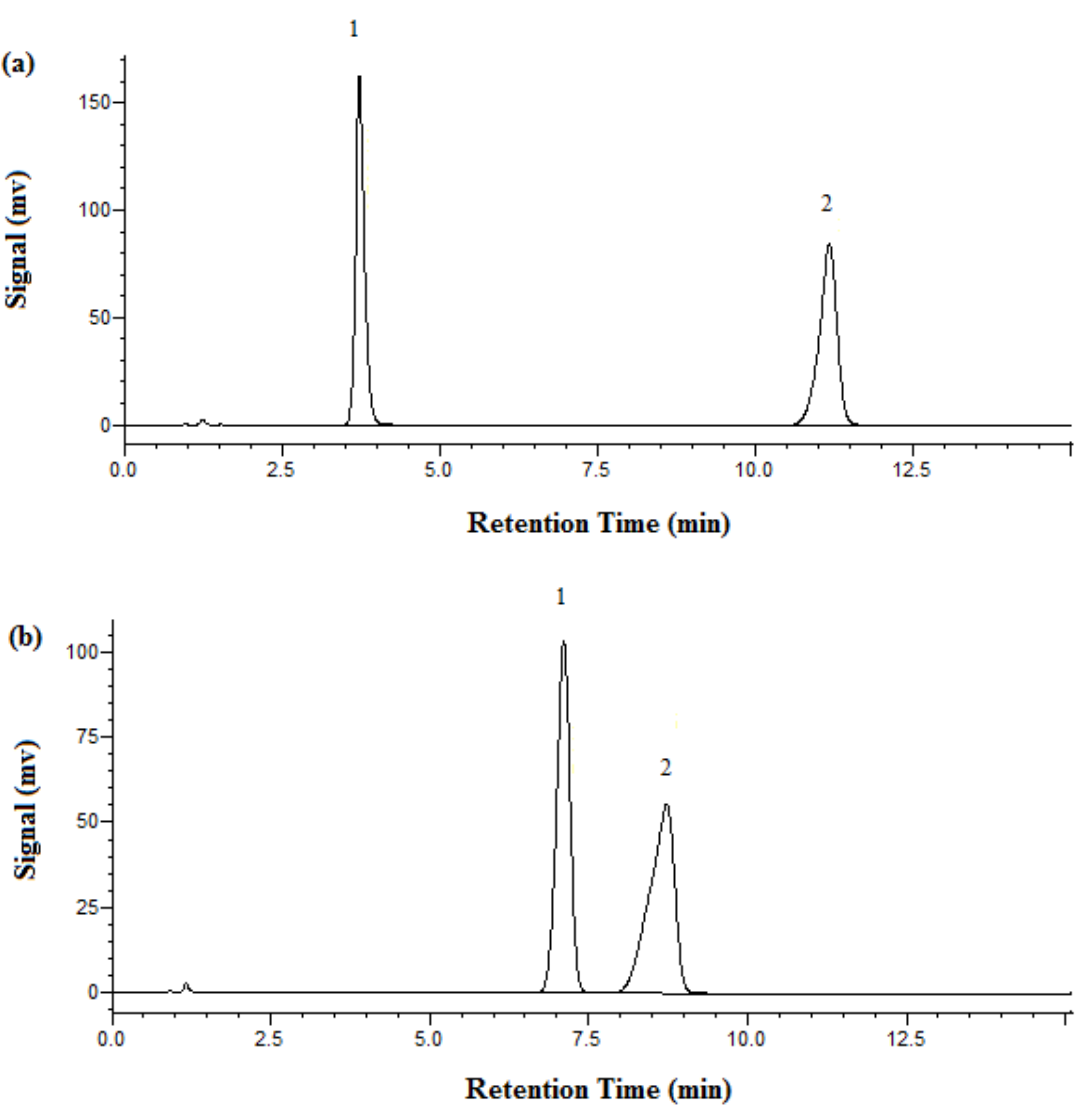
Figure 3. Chromatograms of metformin HCl obtained on the XBridge C18 column with 1 mL/min and UV detection at 218 nm. ( a ) HPLC at 25 °C, mobile phase: 87% phosphate buffer at pH 3.85 and 13% acetonitrile. ( b ) SBWC at 95 °C, mobile phase: 100% phosphate buffer at pH 3.85. Peak identification: 1. metformin, 2. phenol. Table 3. Comparison of metformin HCl quantification results achieved by traditional HPLC and SBWC. Method